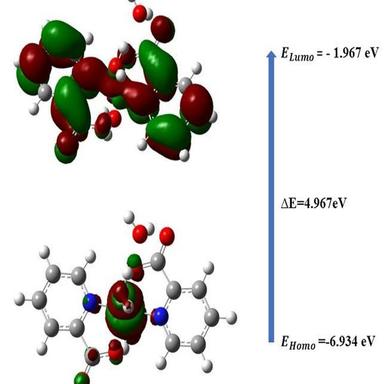
(a) Frontier molecular orbitals and energies for the HOMO and LUMO of PCOH.